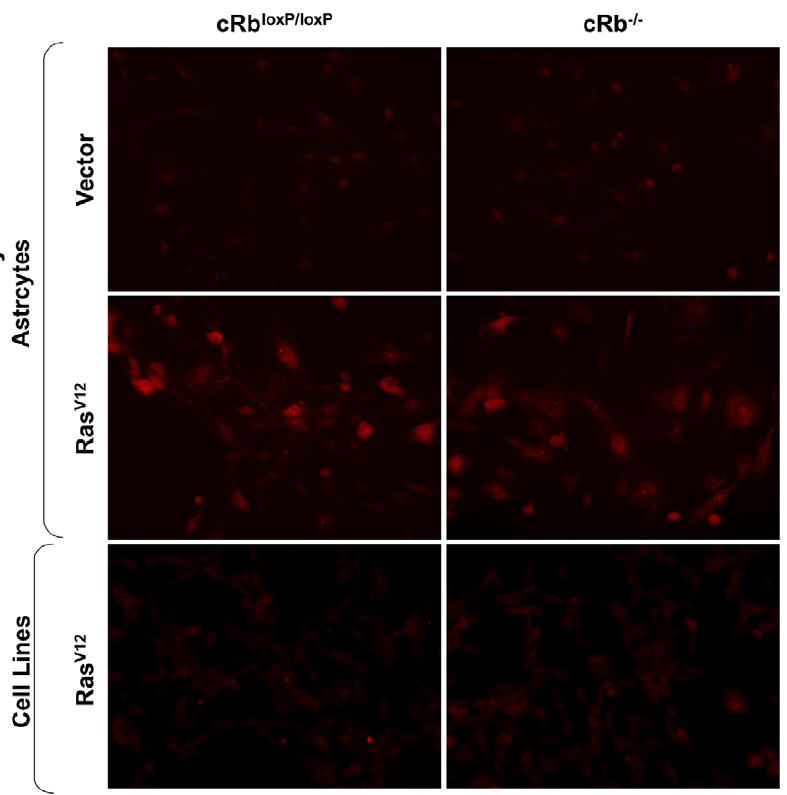
Figure 1. Ras V12 expression increases the levels of ROS. Primary astrocytes and cell lines were assayed for dihydroethidium (DHE) fluorescence, indicative of ROS production, and visualized by fluorescent microscopy. Under identical imaging conditions, DHE oxidation was increased in Rb loxP/loxP /Ras V12 and cRb 2 / 2 /Ras V12